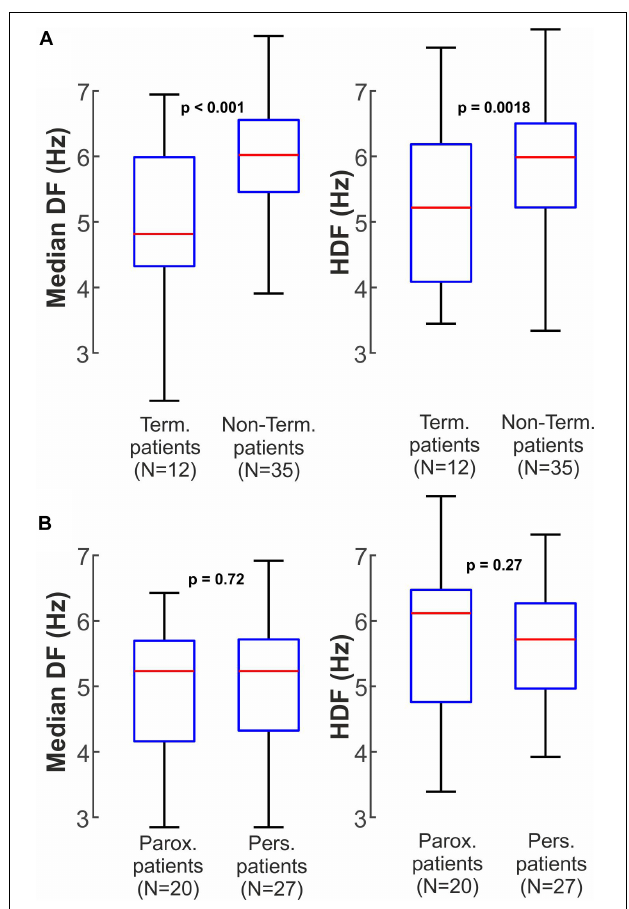
FIGURE 6 | Intracardiac clinical Dominant Frequency measures between different patient groups. (A) Median DF and HDF for patients in which ablation did or did not terminate AF. (B) Median DF and HDF for paroxysmal and persistent AF